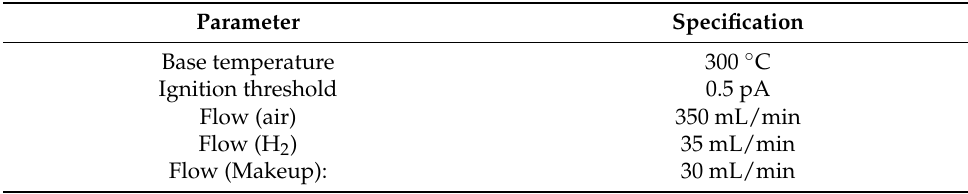
Table 3. FID parameters for all the analyses.